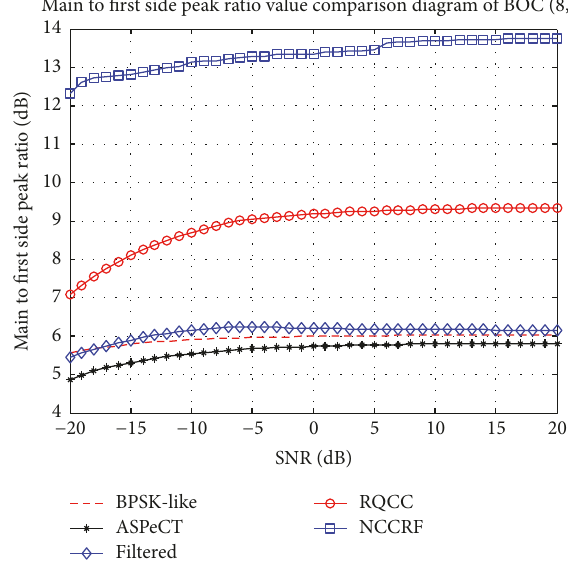
Figure 9: The MSPR comparison of BOC ( 8, 4 ). Main to side peak ratio value comparison diagram of BOC (6,1)